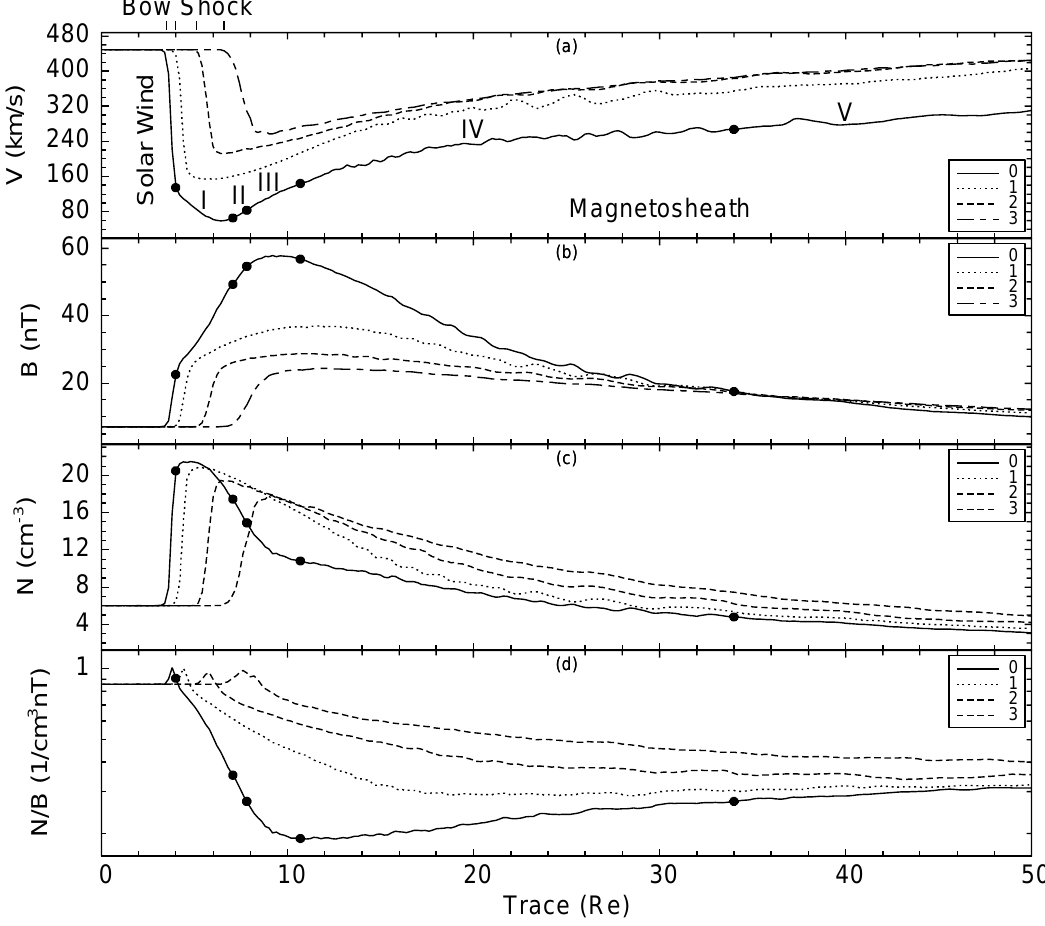
Fig. 9. The flow velocity, the magnetic field magnitude, the plasma density, and the N/B ratio along streamlines 0–3 in the left panel of Fig. 8. The x axis is the distance along a streamline from its starting point in the solar wind. The PDL feature, decreased plasma density and enhanced magnetic field is only seen clearly on streamline 0, which is closest to the magnetopause, from ∼ 6 R E to ∼ 9 R E .